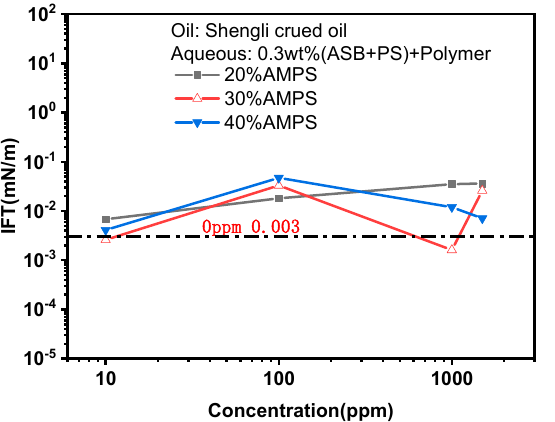
Figure 8. Effect of polymer concentration on equilibrium IFTs between 0.3 wt% ASB@PS solution and Shengli crude oil.